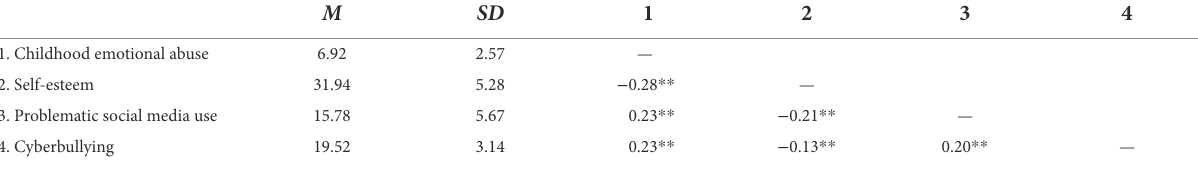
TABLE 1 Descriptive statistics and correlations among